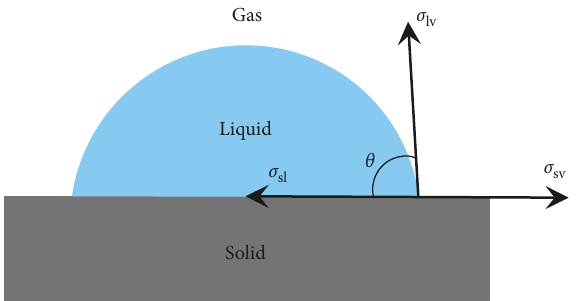
Figure 1: Schematic diagram of droplet contact angle on a smooth solid